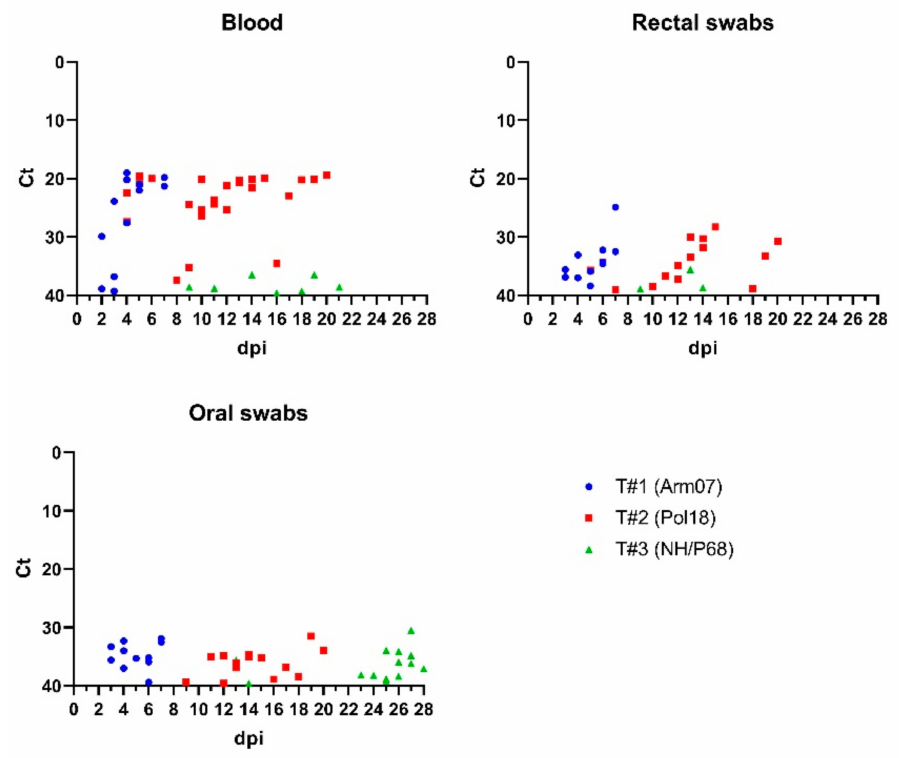
Figure 2. The shedding pattern of viral DNA in different matrices analyzed during animal trials. Lower Ct values in blood in animals infected with virulent strains and high Ct values accompanied by occasional shedding in groups infected with attenuated strain could be seen; Ct—cycle threshold of qPCR, dpi—day post